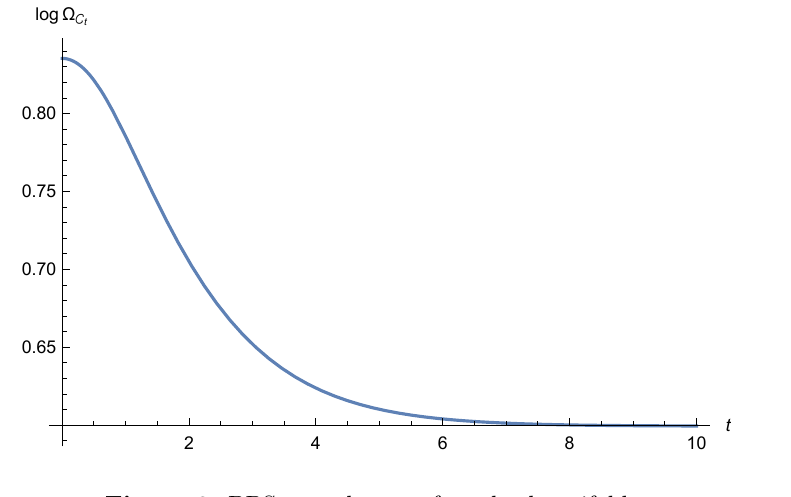
Figure 9 . BPS growth rate of resolved